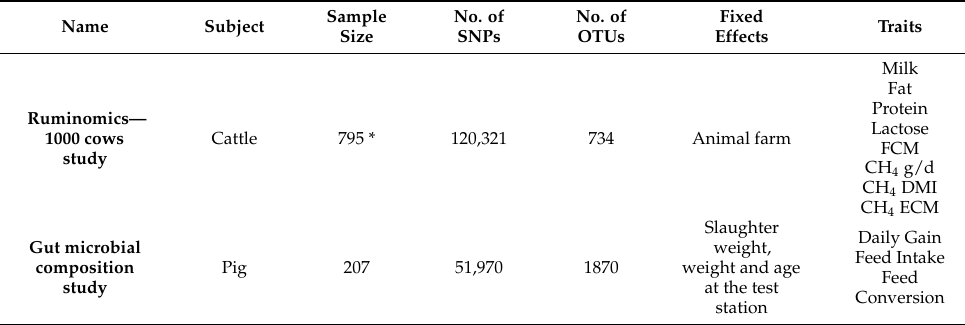
Table 1. Details of real animal datasets used to study prediction